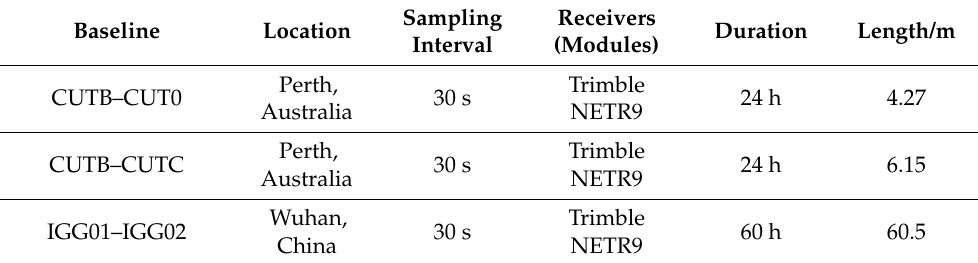
Table 1. Information of the three short baselines used in positioning experiments.